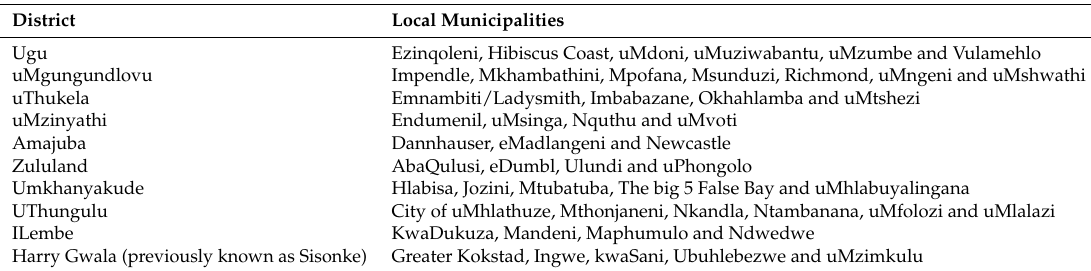
District Local Municipalities